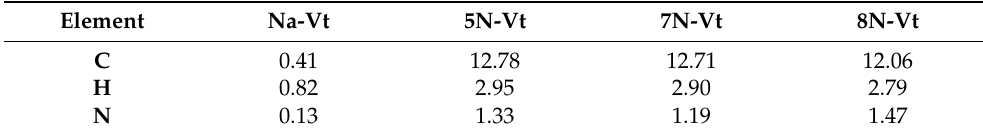
Table 1. The elemental analysis results (wt. %) of Na-Vt and organo-Vts. Element